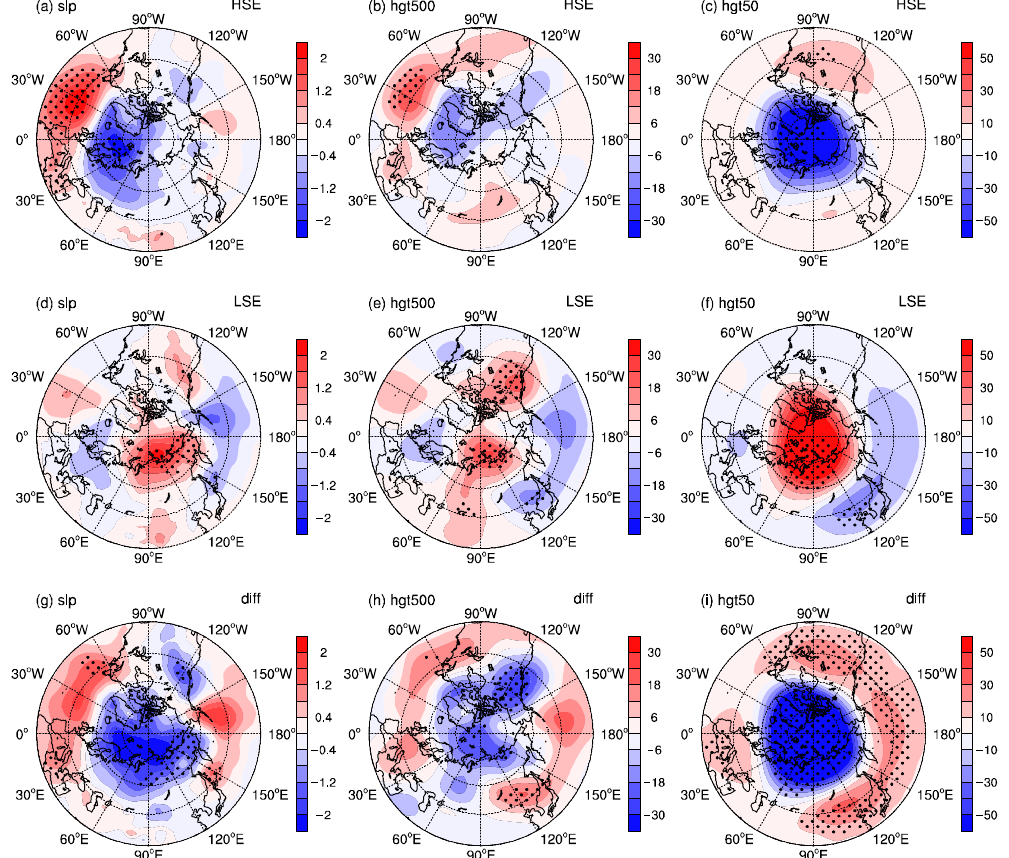
Figure 5. Composite differences in the climatic elements field for the composites of more HSE years and more LSE years in wintertime over NEC: ( a – c ) sea level pressure (units: hPa), 500-hPa geopotential height (units: gpm), and 50-hPa geopotential height (units: gpm) in the composite of more HSE years, respectively; ( d – f ) as in ( a – c ) but for more LSE years; ( g – i ) as in ( a – c ) but for the differences between more HSE years and more LSE years. Stippling denotes where the anomalies are significant at the 90% confidence level.